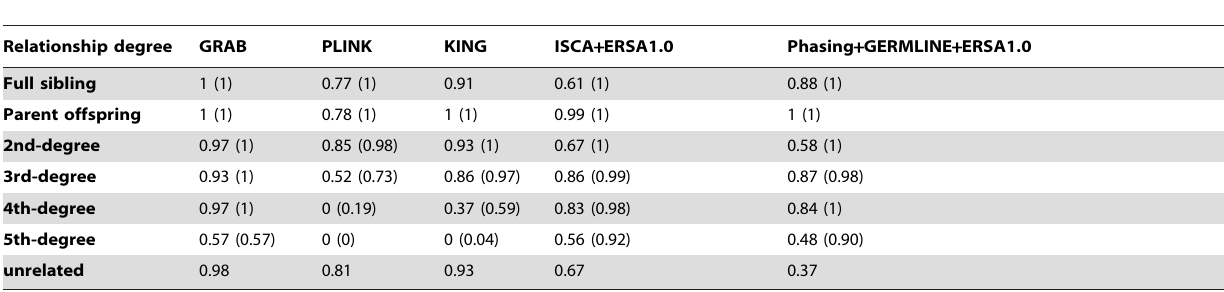
Values in the table are the percentage of correct predictions. Values in parentheses are the percentage of predictions within one degree of the true relationship.